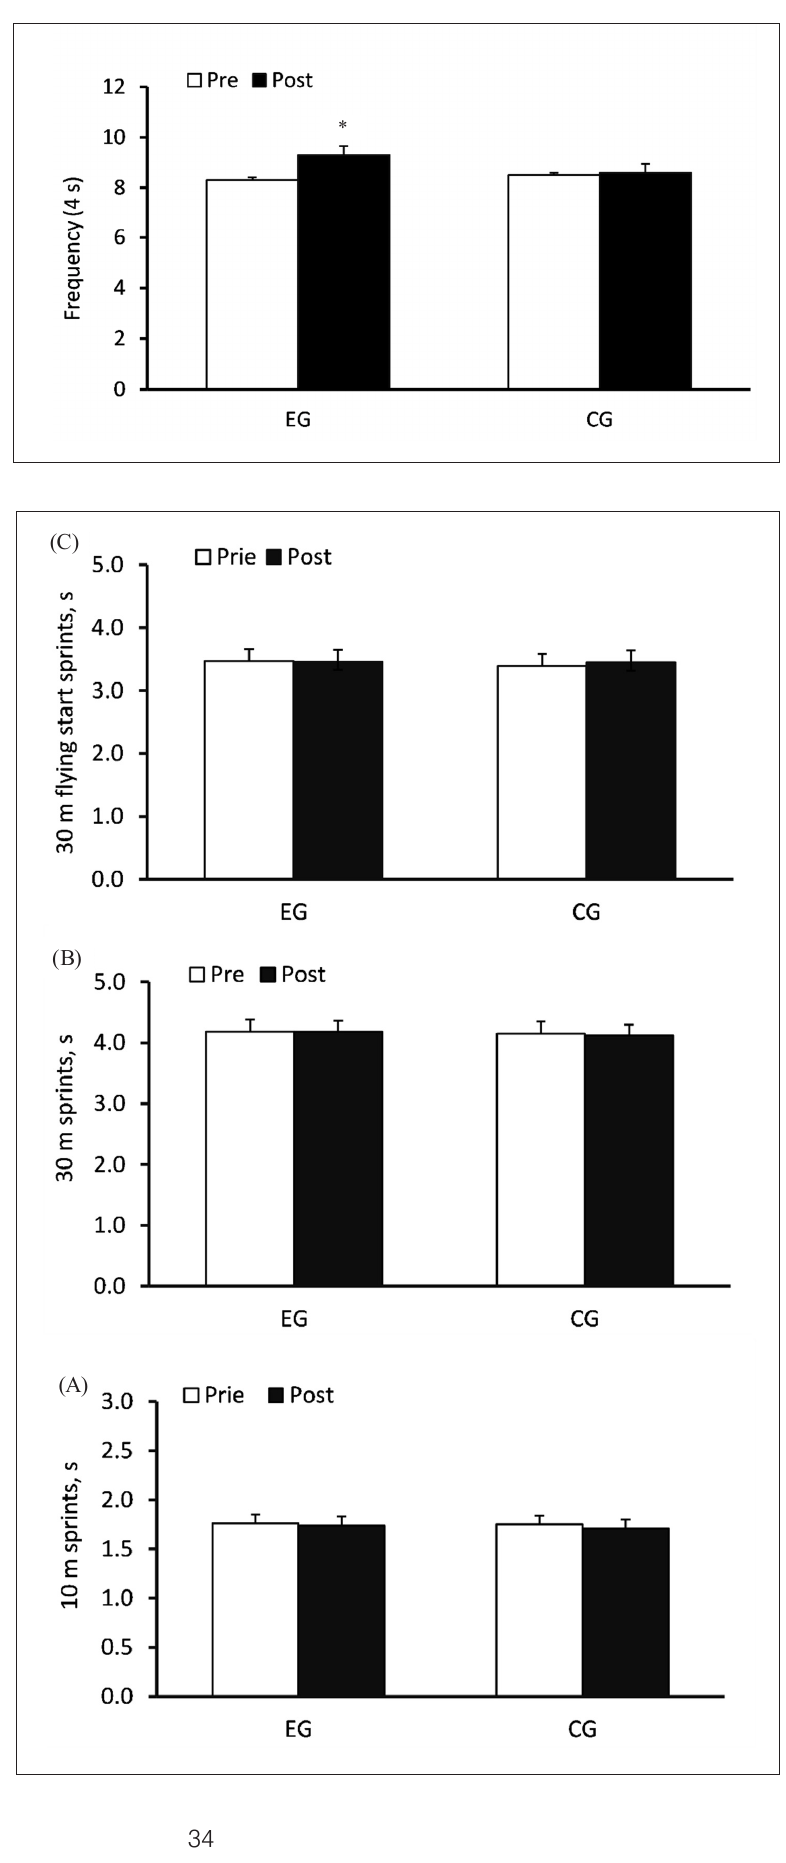
Figure 2. Sprint running performance at 10 m (A), 30 m (B) and 30 m flying start (C) after low resistance high velocity elastic band training (EG) and in the control group (CG) (mean ± SD )